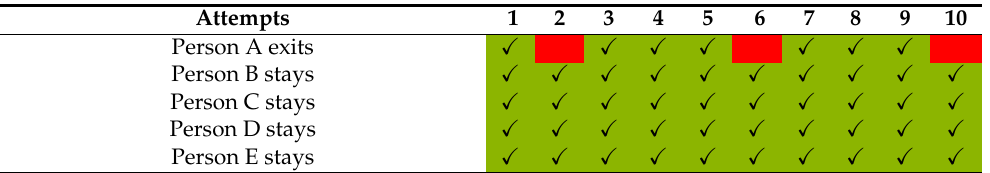
Table 11. Multiple users inside (scalability test) table of results.